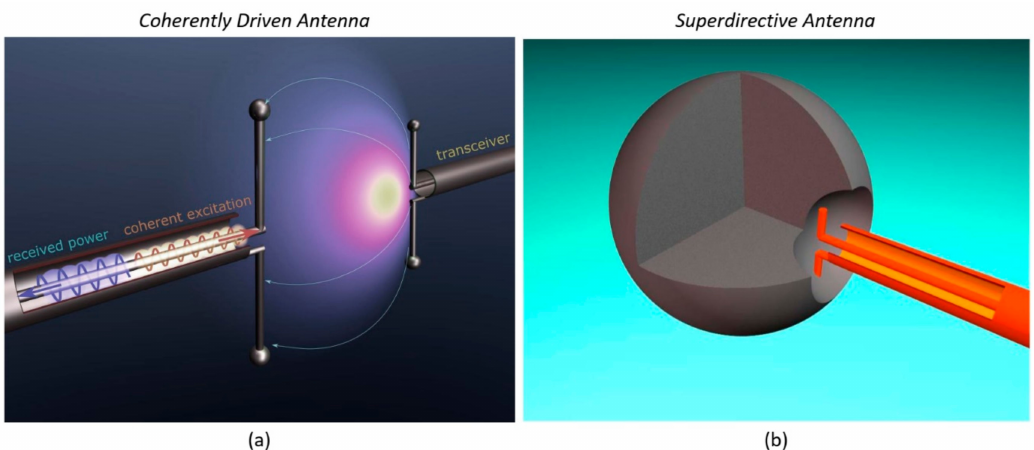
Figure 1. ( a ) Operation principle of coherently enhanced wireless power transfer: a transmitting antenna (right) radiates radio waves to the receiving antenna (left) driven by an additional wave sent from the circuit to the antenna (red wave). ( b ) Superdirective dielectric antenna: subwavelength spherical dielectric resonator (shape can be di ff erent) with a small notch on its surface fed by a short dipole source placed into the notch. Inhomogeneous near field of the dipole source excites high-order multipoles in the resonator which radiate coherently and can form the superdirectivity regime. Reprinted with permission from